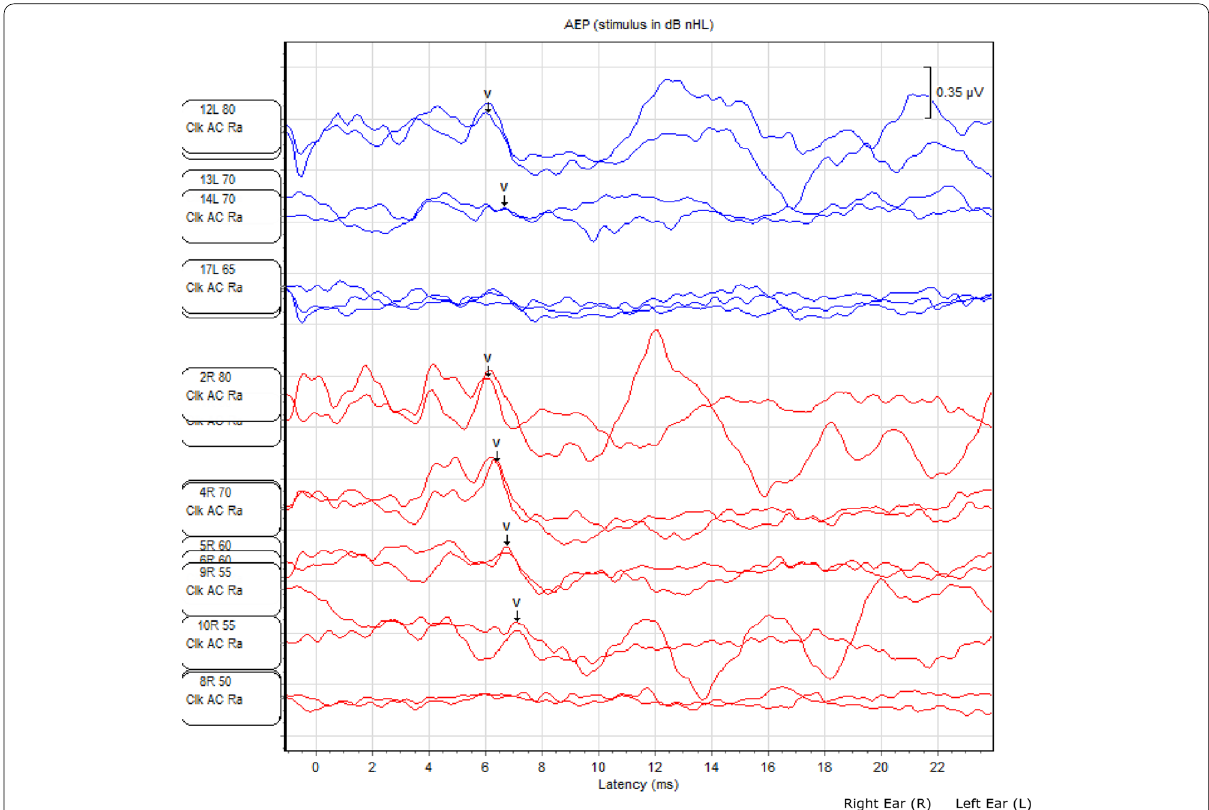
Fig. 4 The result of the ABR performed at our clinic on January 10,